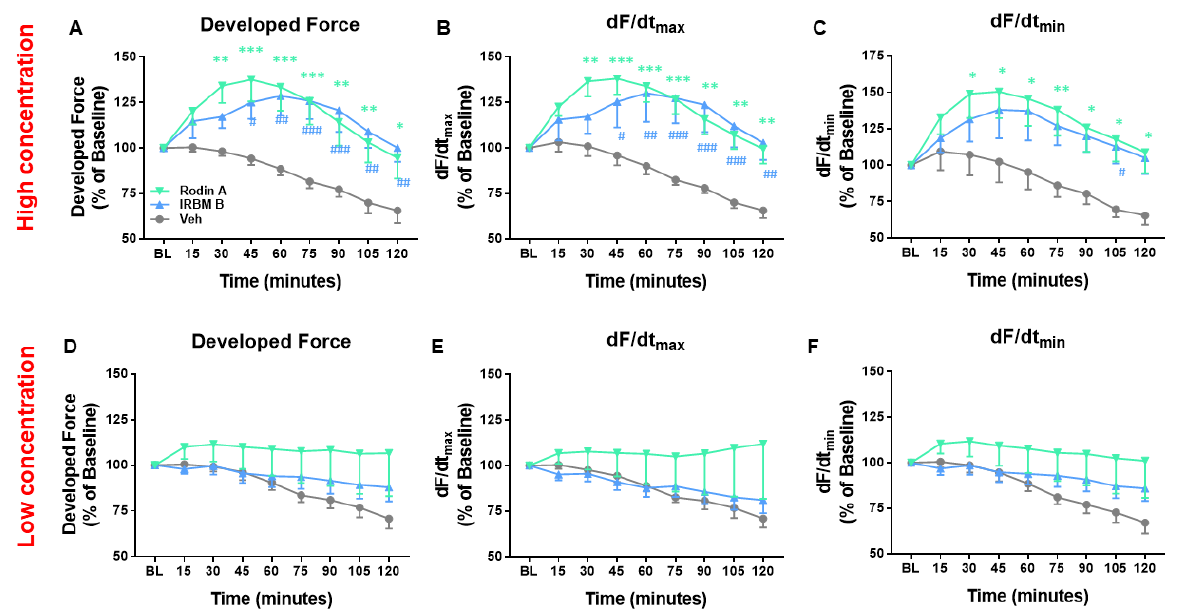
Figure 6. Effect of isoform selective HDAC inhibition on non-failing human trabeculae. Trabeculae were isolated from right atrial appendages (RAA) and treated with Rodin-A, IRBM-D, or vehicle at high or low concentrations. ( A ) Developed force, ( B ) dF/dt max , and ( C ) dF/dt min were all increased with high concentrations of Rodin-A and IRBM-D compared to vehicle treatment. There was no significant difference ( D ) developed force, ( E ) dF/dt max , and ( F ) dF/dt min in the lower concentration-treated groups compared to vehicle; high concentration: Rodin-A, n = 8 trabeculae; IRBM-D, n = 9 trabeculae; low concentration: Rodin-A, n = 7 trabeculae; IRBM-D, n = 13 trabeculae; vehicle, n = 8 trabeculae. RAA trabeculae were isolated from 30 patients. All analysis was performed using repeated measure two-way ANOVA. * p < 0.05, ** p < 0.01, *** p < 0.001 Rodin-A vs. vehicle, # p < 0.05, ## p < 0.01, ### p < 0.001 IRBM-D vs. vehicle. Data shown are means ± SEM.